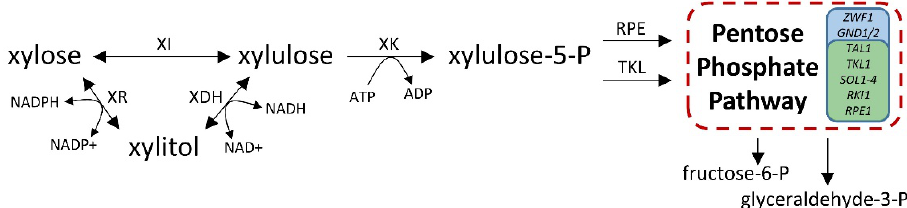
Figure 1. Xylose metabolism in engineered Saccharomyces cerevisiae strains. Two of the main routes for xylose metabolism are shown. A third route via the Weimberg pathway was not investigated in this study and is not shown above. Enzyme activities and genes required for xylose metabolism are: XR, D-xylose reductase (E.C. 1.1.1.21); XDH, xylitol dehydrogenase (E.C. 1.1.1.9); XI, D-xylose iso-